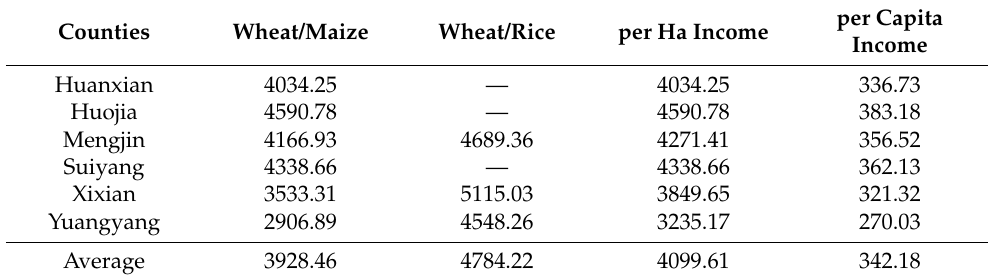
Table 4. Farming income from traditional planting patterns in selected counties (unit: USD).